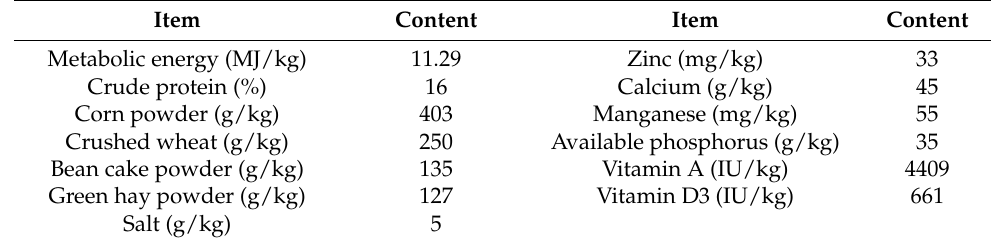
Table 1. Composition and nutrient content of experimental diet (air-dry basis).